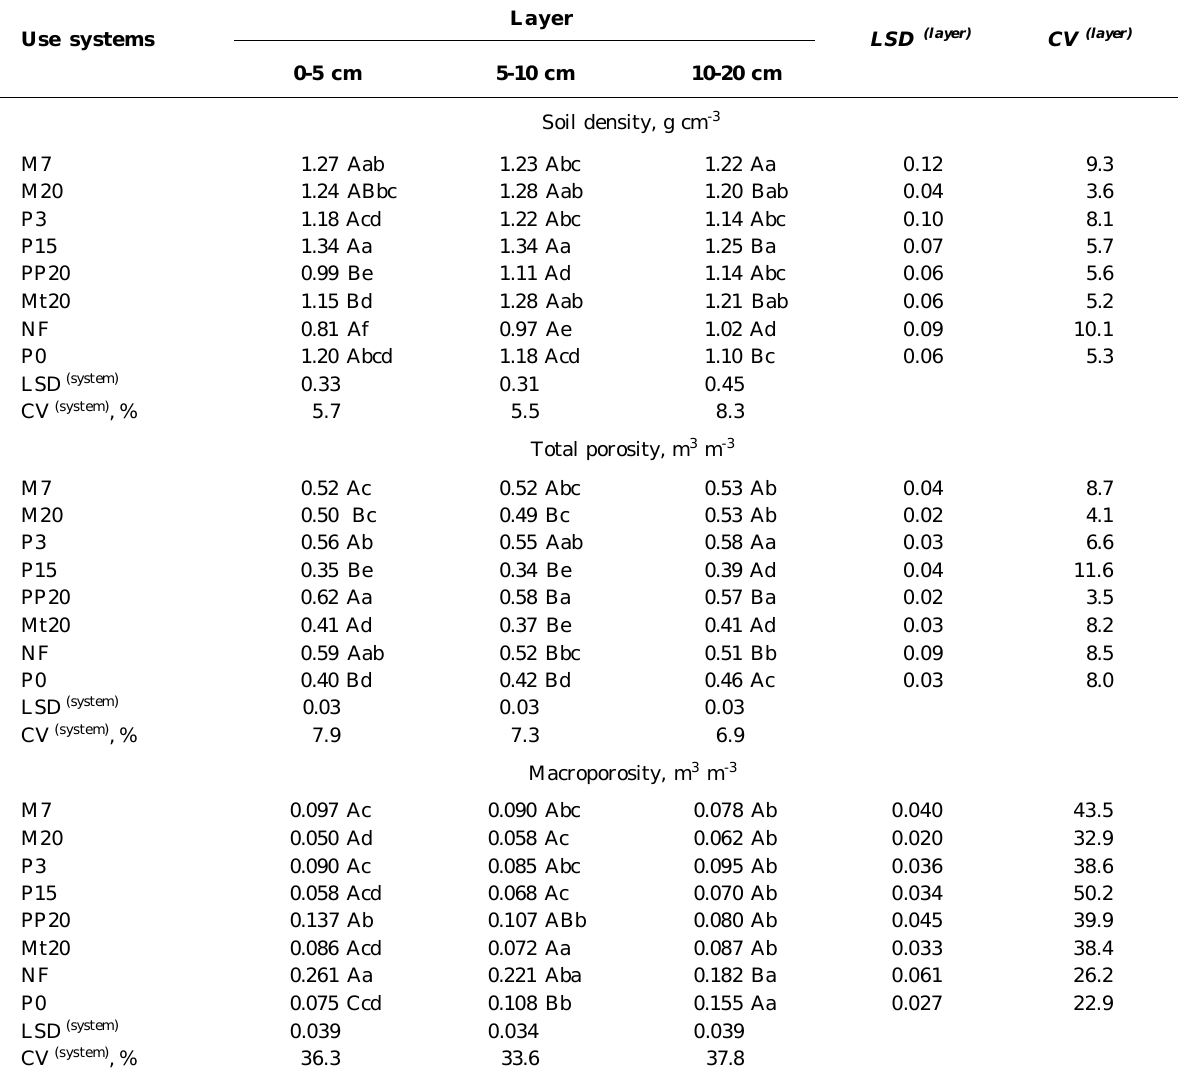
Table 6. Soil bulk density (Db), total porosity (PT) and macroporosity (Macro), in areas under different